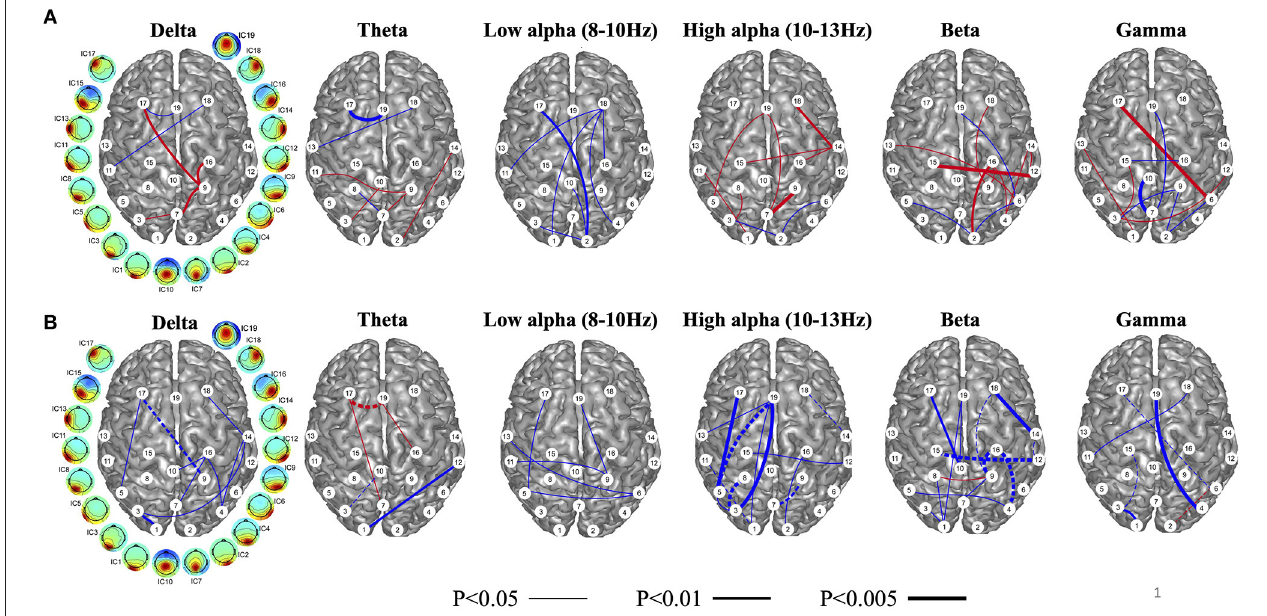
FIGURE 6 | Independent component phase coherence (ICPC) changes reflected as increases (blue) and decreases (red) of ICPC as a function of treatment response to repetitive transcranial magnetic stimulation (rTMS) over the dorsolateral prefrontal cortex (DLPFC) (A) . As a function of treatment response, connectivity in the high alpha, beta, and gamma, and delta bands decrease, while connectivity in the low alpha band increases with treatment response. Changes in the theta frequency are mixed. Baseline connectivity as a function of treatment response (blue represents high, and red represents low) in (B) . Baseline connectivity is high across all frequency bands in treatment responders. Lines connecting independent components are weighted for higher statistical significance. Dashed lines indicate connectivity that both changes and predicts treatment response. Figure adapted from Cha YH et al., Brain Connectivity 2018 (